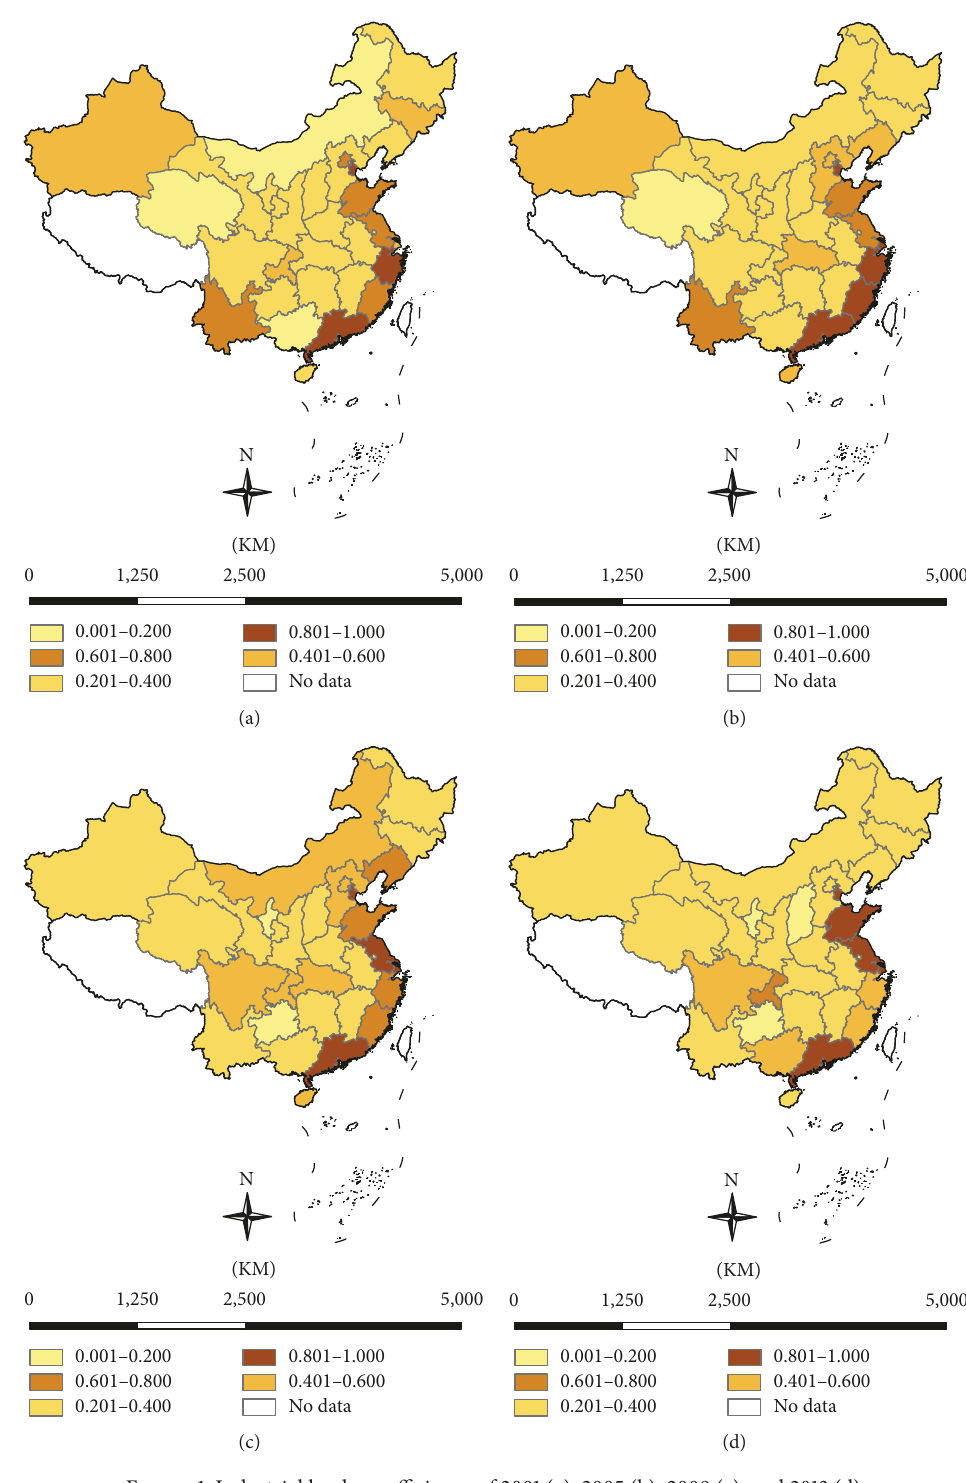
Figure 1: Industrial land use efficiency of 2001 (a), 2005 (b), 2009 (c), and 2013 (d).